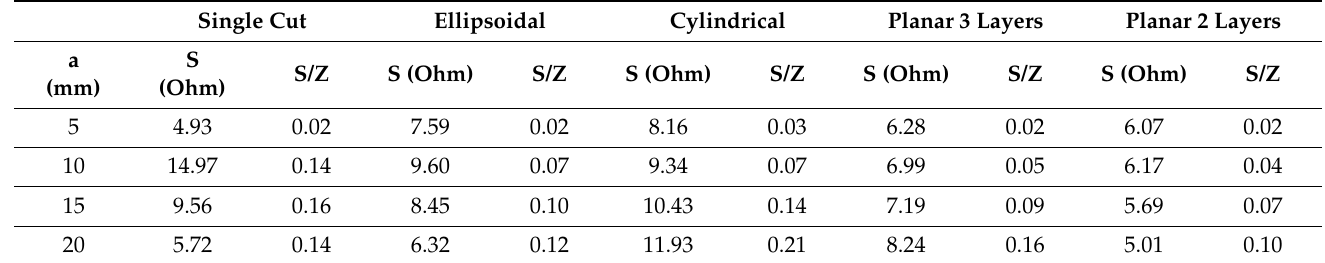
Table 1. The error in simplifying the EI models in comparison with the